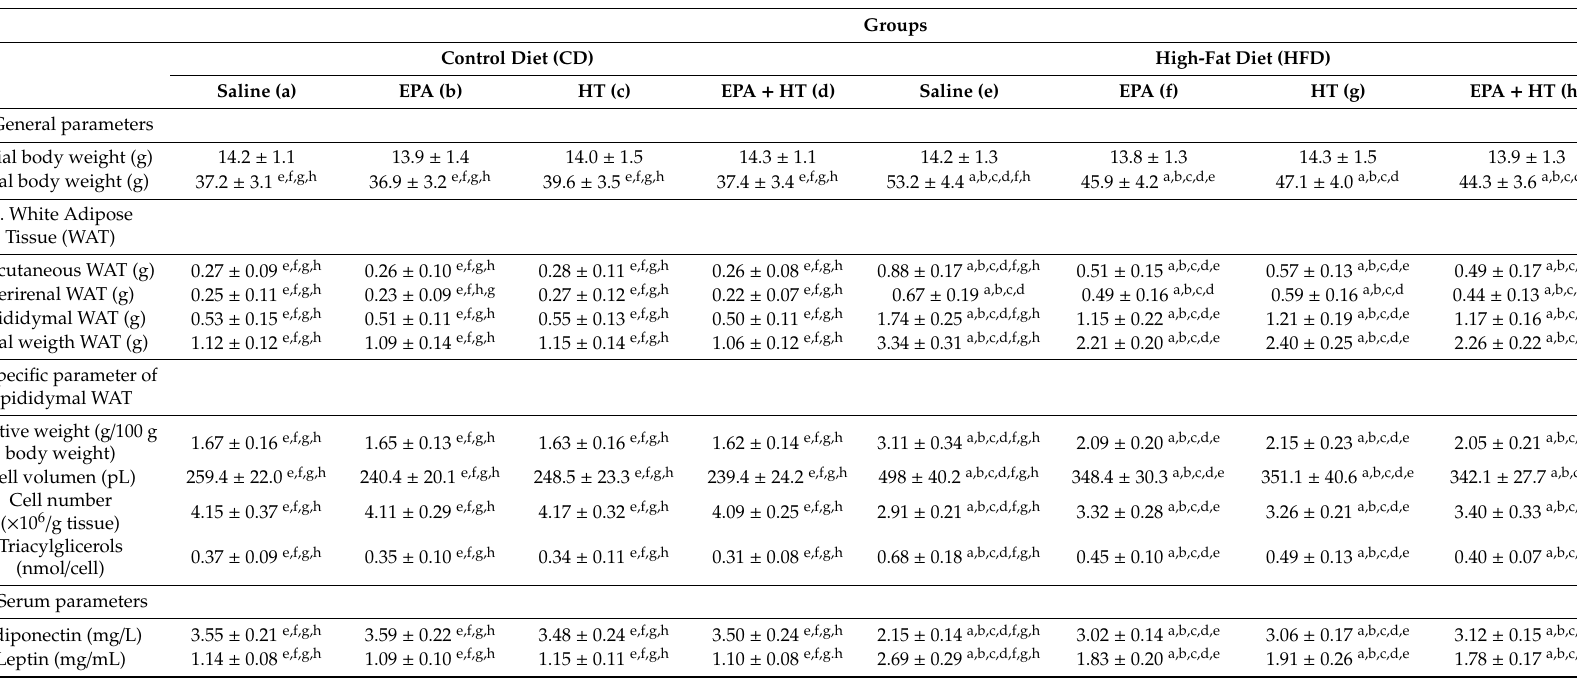
Table 2. General and metabolic parameters in control diet (CD) and high-fat diet (HFD)-fed mice subjected to eicosapentaenoic acid (EPA), hydroxytyrosol (HT) or EPA + HT